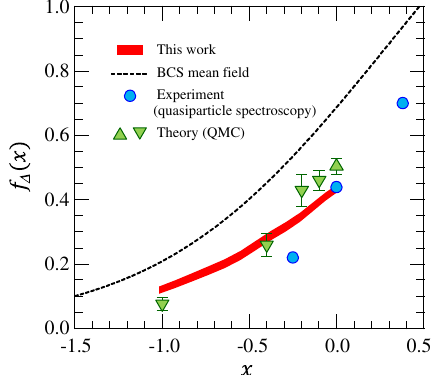
FIG. 10. Dimensionless superfluid gap. The red curve indicates the gap calculated by substituting our f μ ð x Þ into the gap equation in Eq. (31). The dashed black curve was obtained by BCS-MF calculation [42]. The green triangle and the green inverse triangles indicate the theoretical values obtained by the QMC method [43,44]. The blue circles are experimental values obtained by quasiparticle spectroscopy